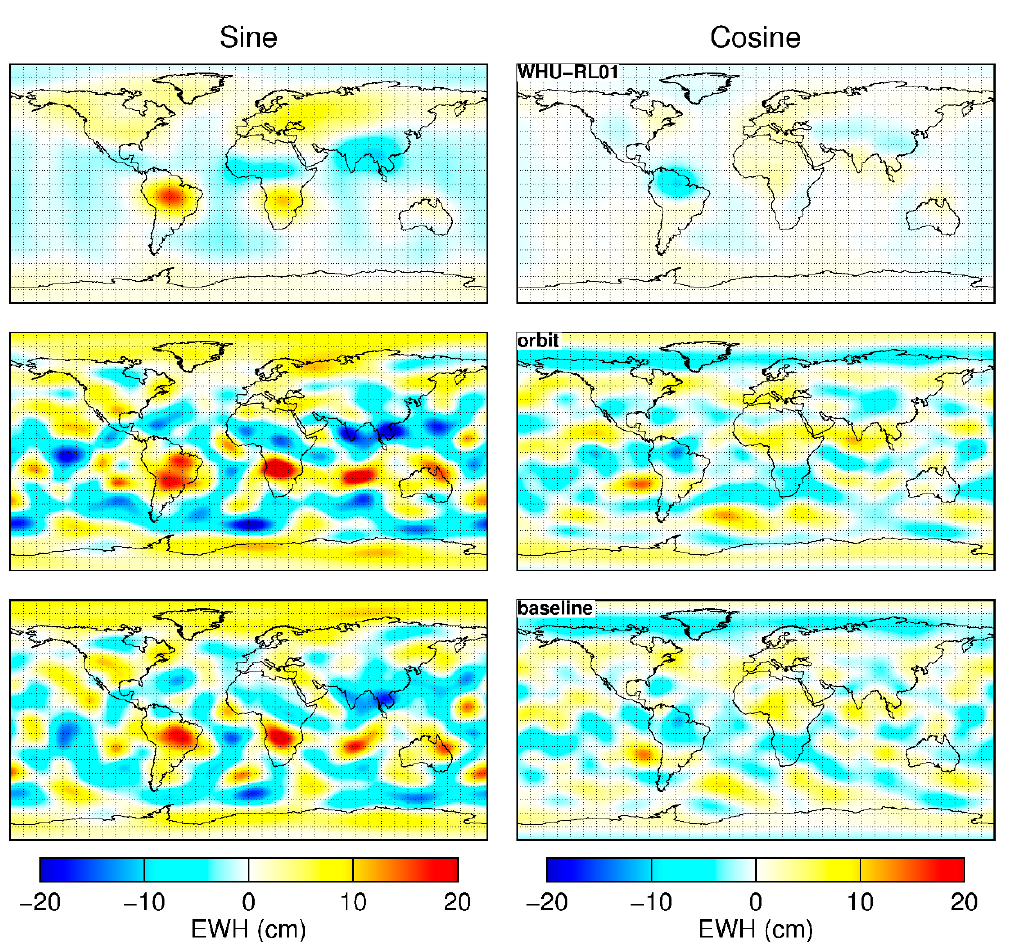
Figure 5. Same as in Figure 4, but for the G1000 filtered solutions.